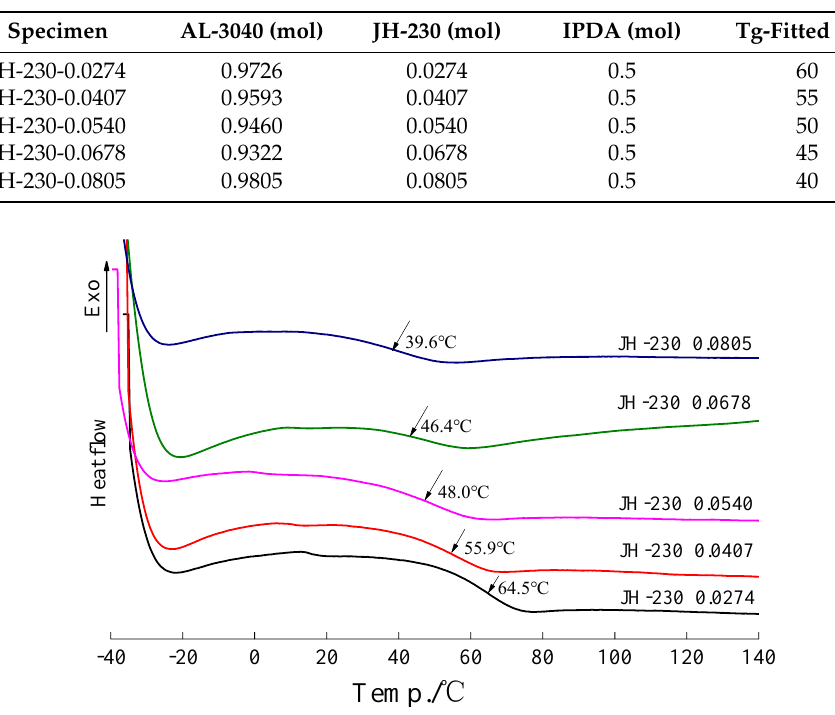
Table 2. Specimens with back-calculated formulations and their T g values.